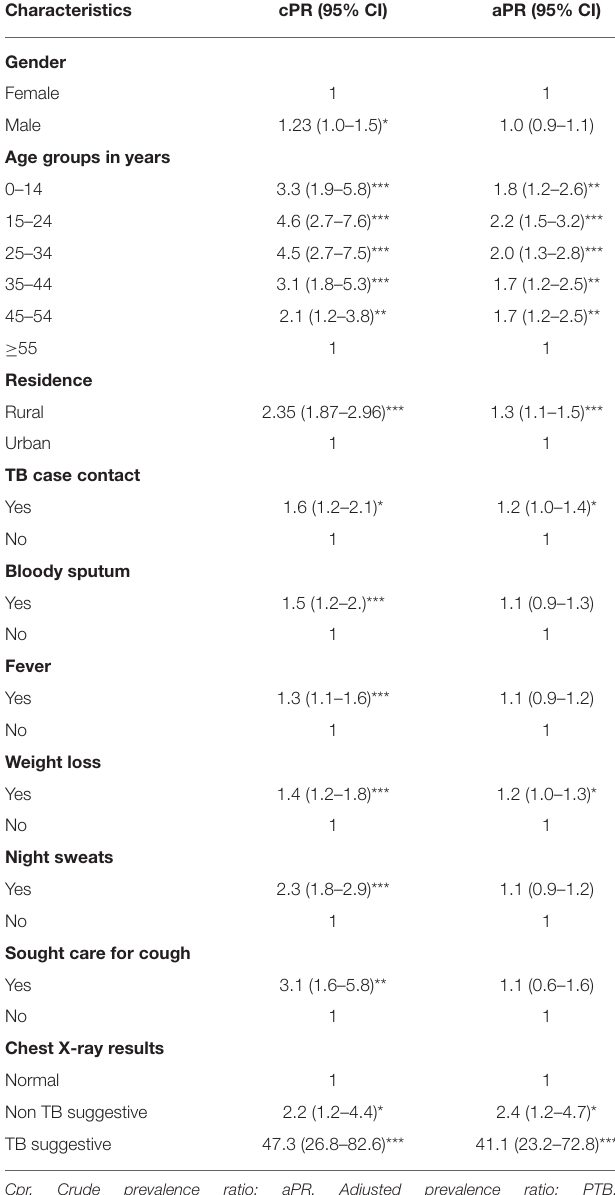
TABLE 4 | Factor associated to pulmonary TB among presumptive TB cases at health facilities, Ethiopia.